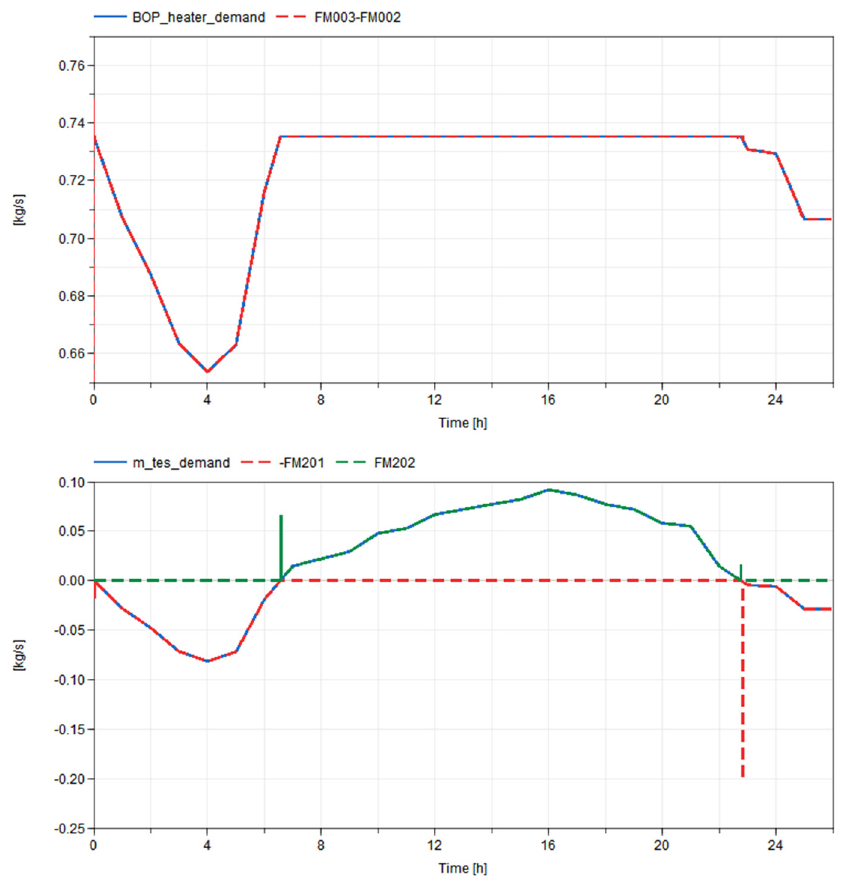
Figure 16. Hot-Summer-Day Scenario: ( Top ) Balance-of-plant mass flow rate. ( Bottom ) Thermal-energy storage mass flow rate vs. sensor reading.